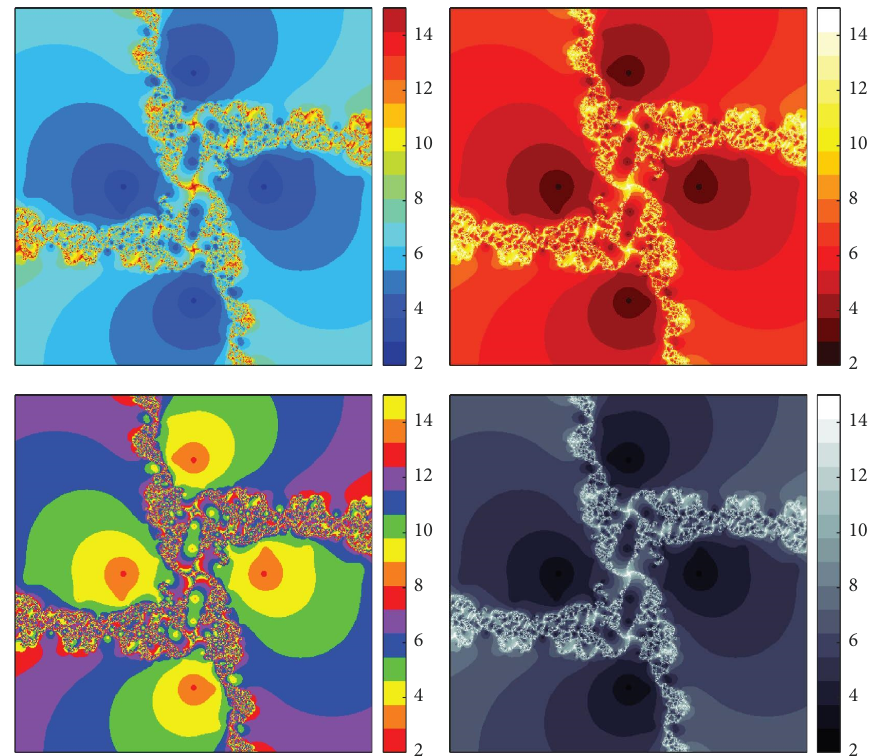
Figure 18: Examples of polynomiographs of diferent color maps for p